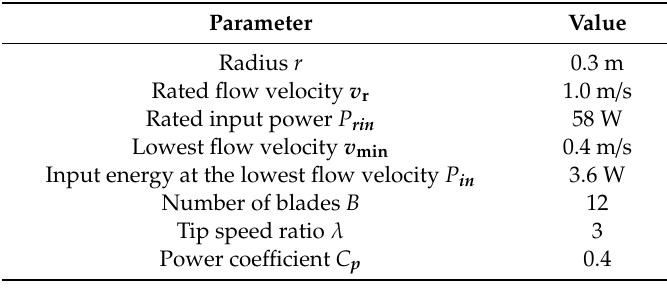
Table 2. The parameters of the turbine.